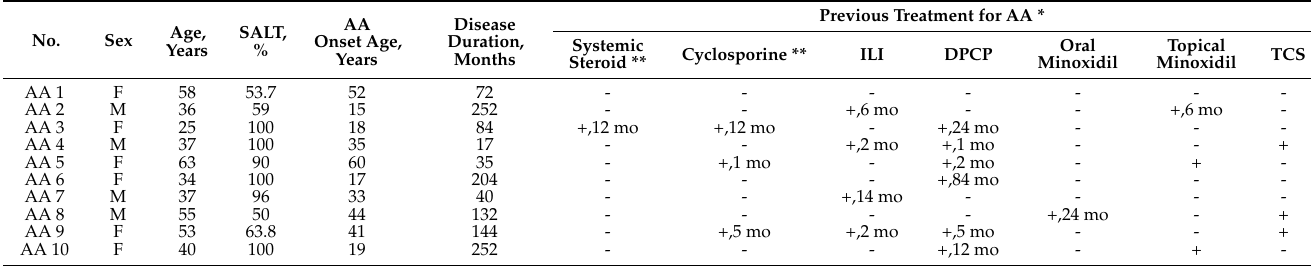
Table 2. Clinical characteristics of AA patients.